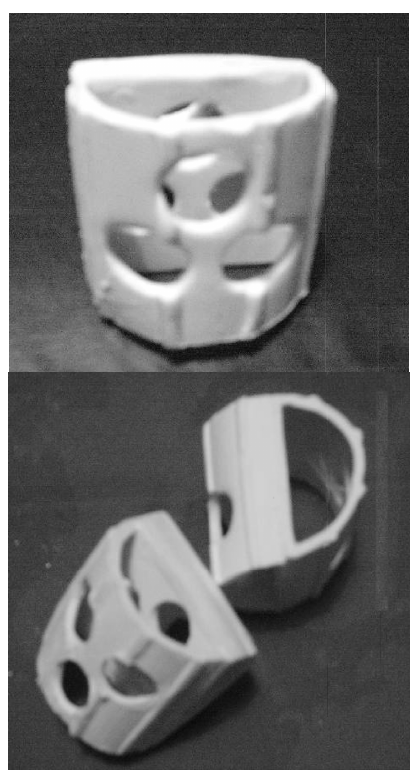
Fig. 4. New ceramic pаcking N3C